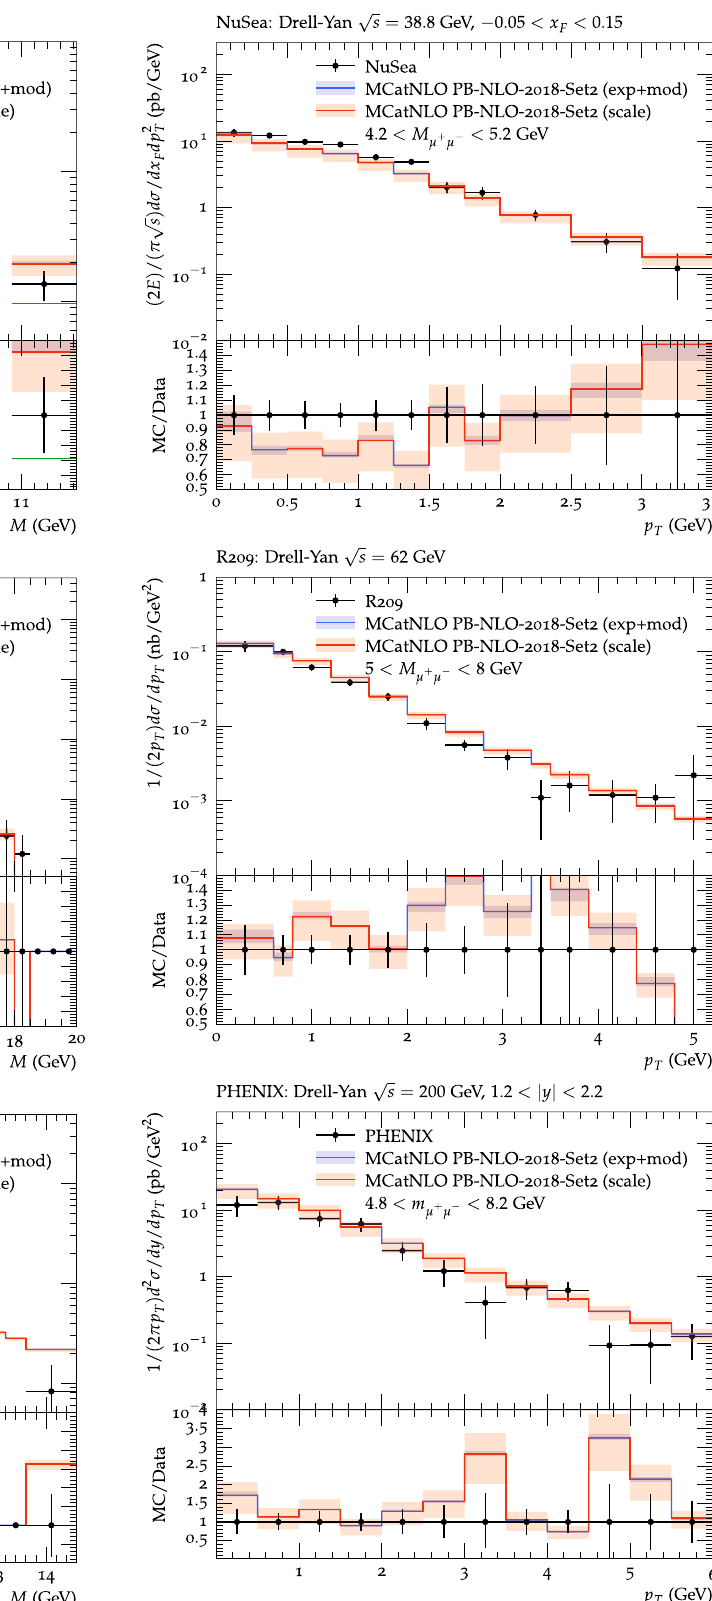
Fig. 6 Transverse momentum spectrum of Drell–Yan production mea- sured by NuSea [42,43], R209 [41], PHENIX [40] compared to predic- tions at NLO using